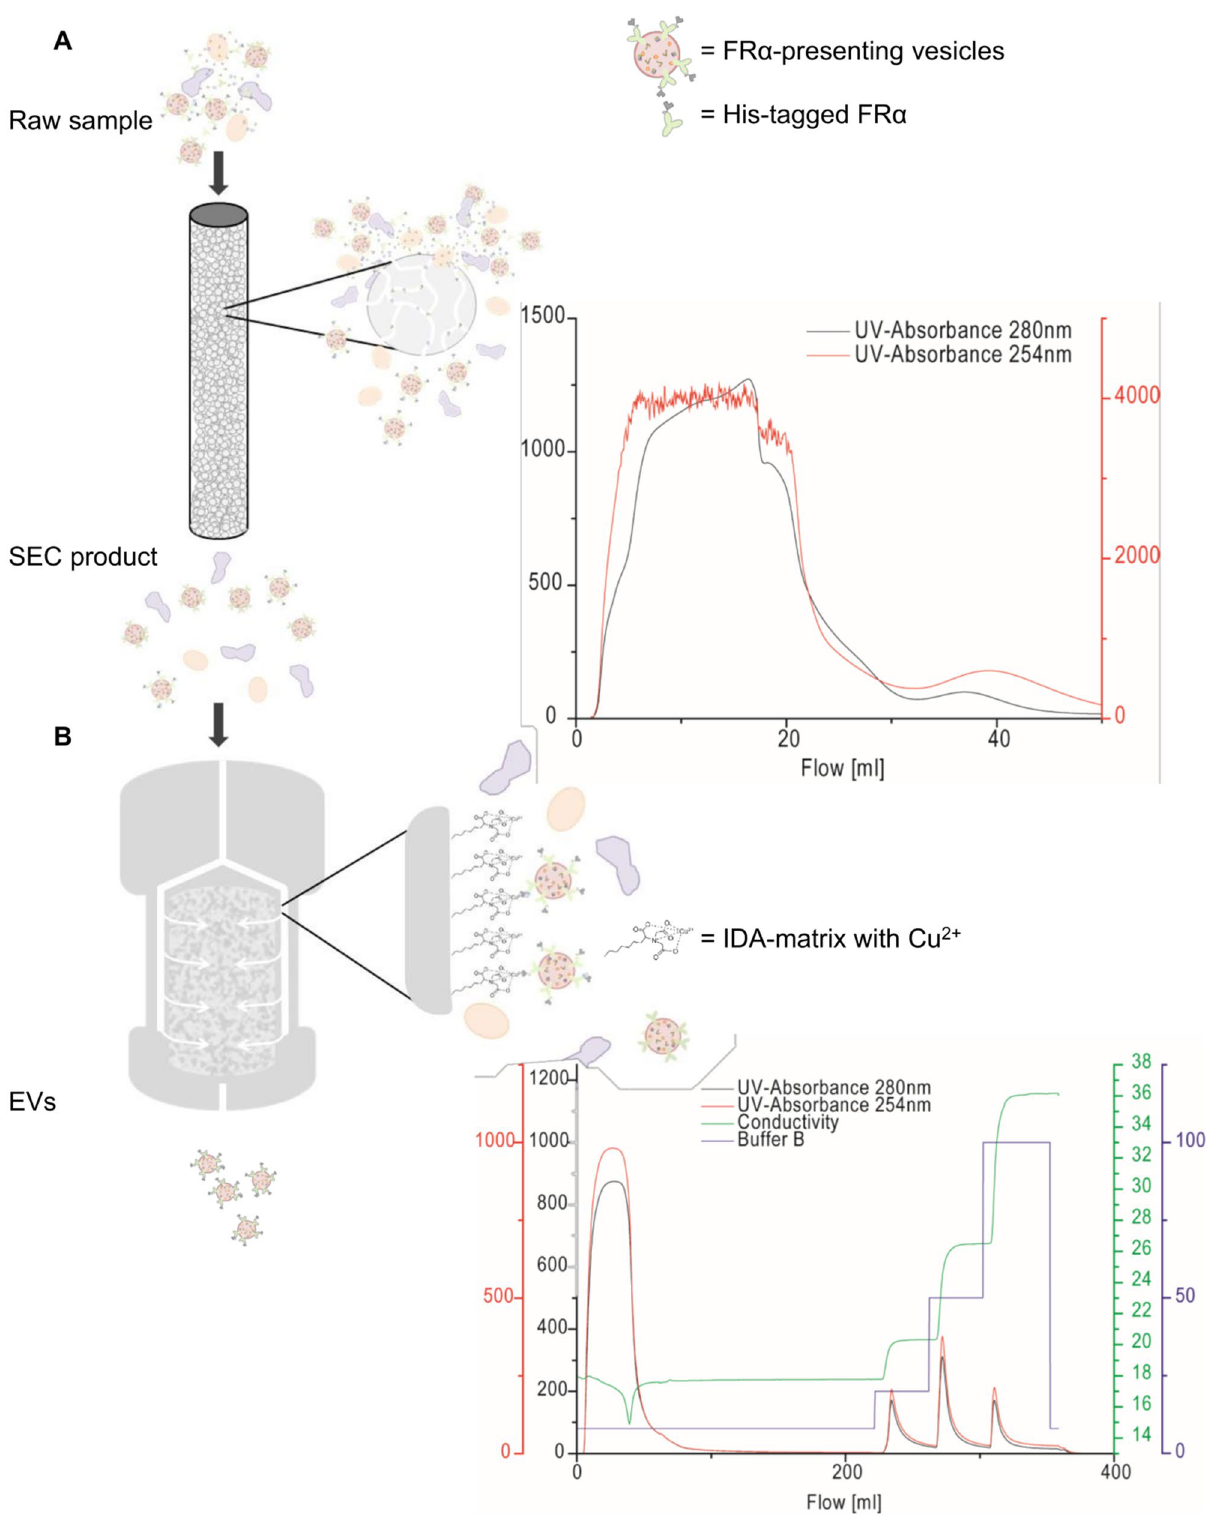
Figure 1. Scheme of two-step FPLC purification of his-tagged vesicles. ( A ) Samples with polyhistidine- tagged vesicles were applied to the SEC and small contaminating particles were retained in the hydrophobic and positively charged pores. The chromatogram resembled a flow-through rather than a gel filtration, as it is expected for this material, Capto Core 700. The sample volume in this example was about 20 ml. ( B ) Subsequently, the sample was applied to the copper-charged monolithic column. Polyhistidine-tagged particles bound to the Cu-atom and were then eluted with imidazole-containing Buffer B. As seen in the chromatogram, the major peak resulted from the second gradient step with 50% of buffer